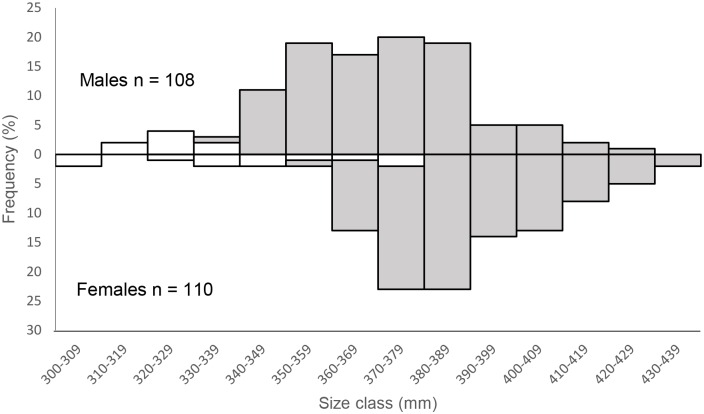
Length-frequency of immature (white) and mature (grey) Asymbolus pallidus individuals.